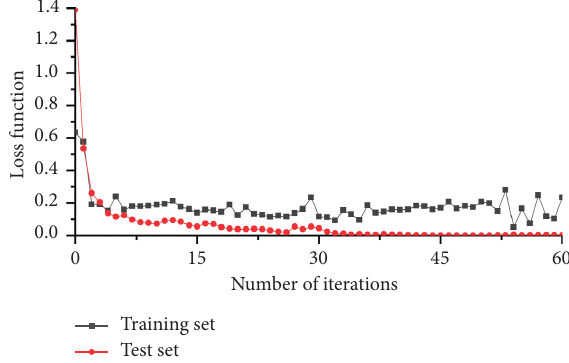
Figure 17: Sample loss function value change curves during model iteration.